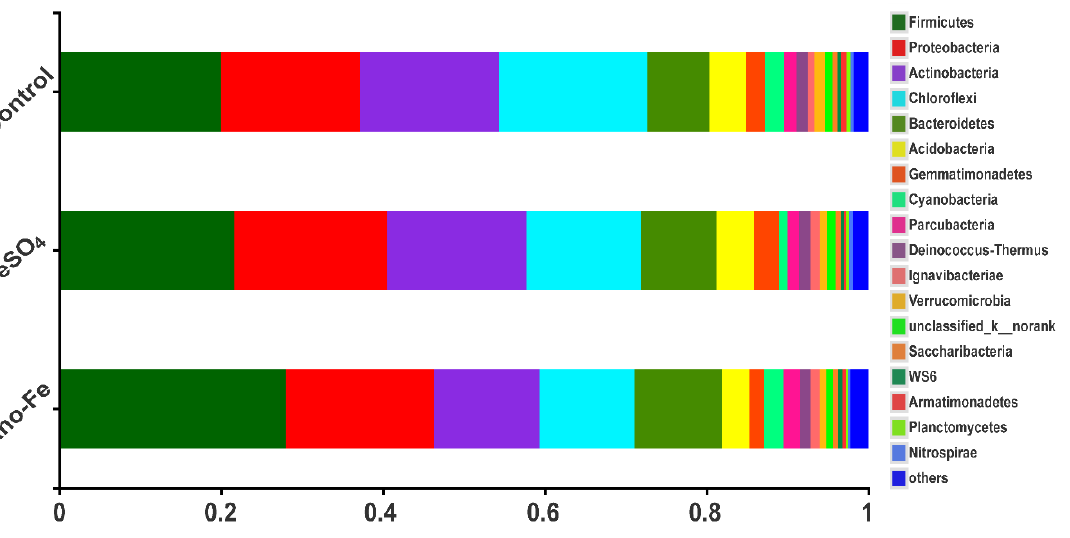
Figure 5. The relative levels of abundance of phyla in treatments with exogenous Fe applied as FeSO 4 or Nano-Fe.